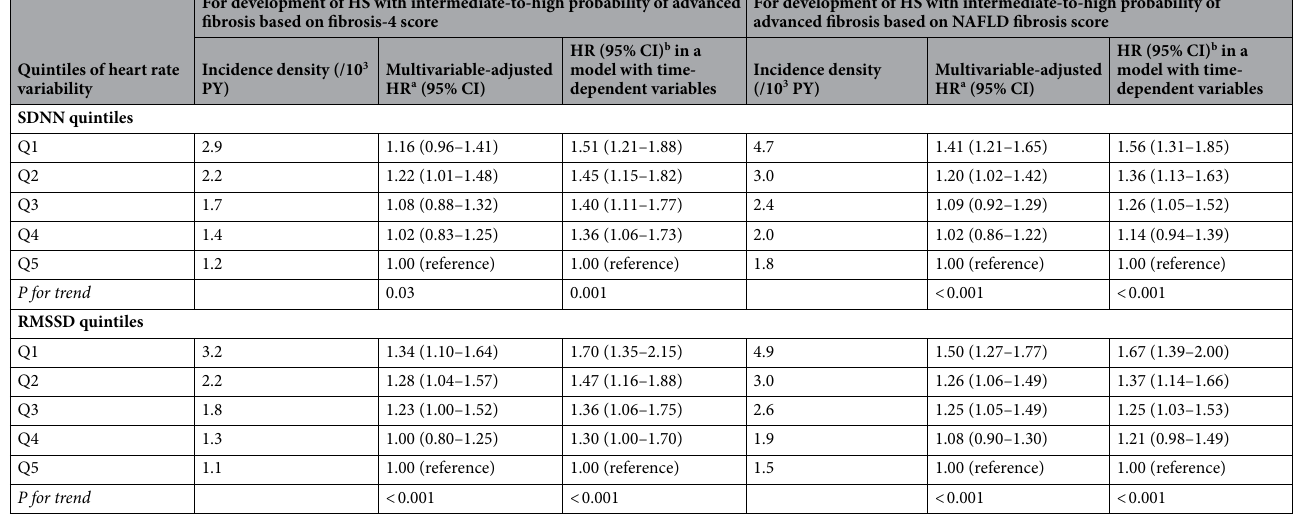
Table 3. Hazard ratios (95% CI) for development of hepatic steatosis with intermediate-to-high probability of advanced fibrosis based on fibrosis-4 score and NAFLD fibrosis score by heart rate variability. a Estimated from parametric proportional hazard models. The multivariable model was adjusted for age, sex, study centre, year of screening examination, smoking, alcohol consumption, physical activity, depressive symptoms, sleep duration, education level, total energy intake, and systolic blood pressure. b Estimated from parametric proportional hazard models with quintiles of each heart rate variability (SDNN, RMSSD), smoking, alcohol consumption, physical activity, depressive symptoms, sleep duration, total energy intake and systolic blood pressure as time-dependent categorical variables; and baseline age, sex, centre, year of screening exam, and education level as time-fixed variables. CI confidence interval, HR hazard ratio, HS hepatic steatosis, PY person-year, RMSSD root mean square of successive differences in RR intervals, SDNN standard deviation of normal-to-normal